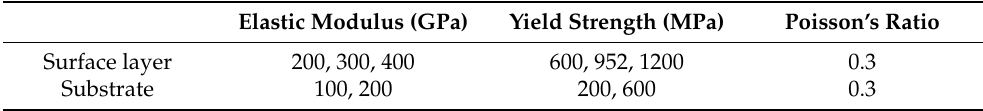
Table 2. Material parameters used in the finite element